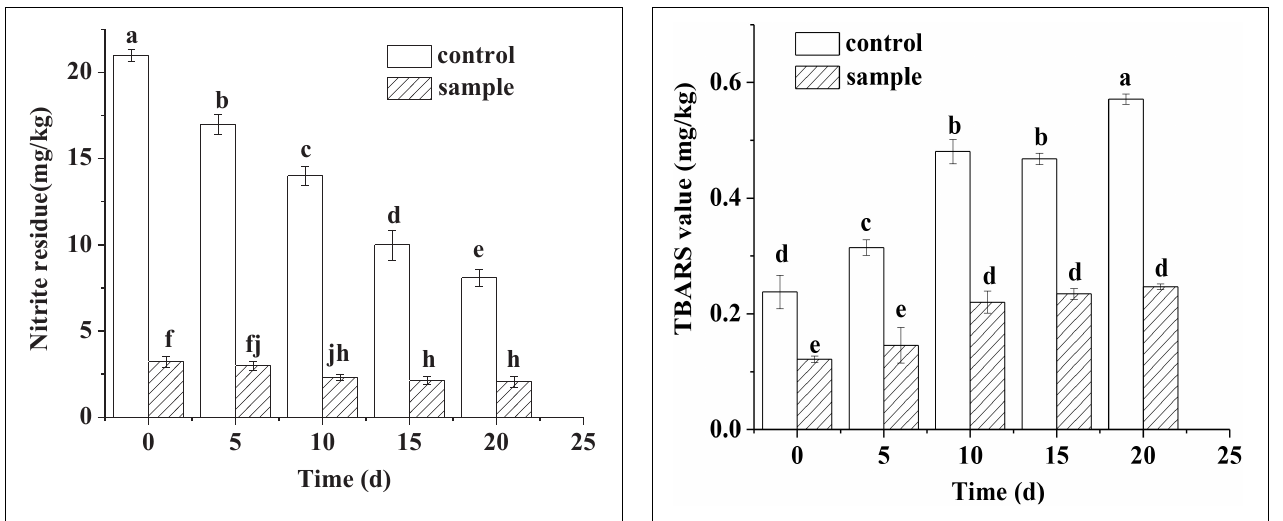
FIGURE 2 | The nitrite content of the sausages during ripening period, in which different lowercase letters meant that nitrite content was significantly different ( p < 0.05).